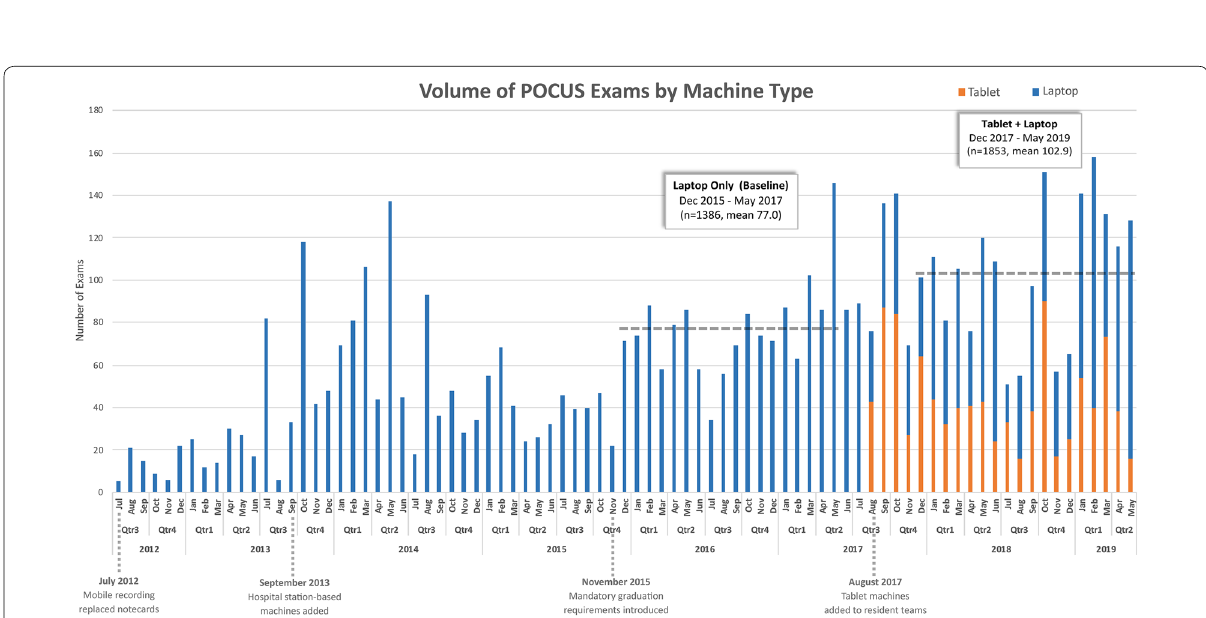
Fig. 2 Volume of POCUS exams by month within the IMBUS program, limited to those performed by residents on inpatient rotations. Baseline (station-based laptop ultrasound devices only) period (December 2015–May 2017) and intervention (station-based laptop devices devices) period (December 2017–May 2019) with horizontal dashed lines representing the mean number of exams for each period (77.0 vs. 102.9). Proportions of exams performed by device type from August 2017 through May 2019 are shown with orange (tablet) vs. blue (laptop) bars. The timeline shown annotates significant historical programmatic changes impacting volume of exams within the IMBUS